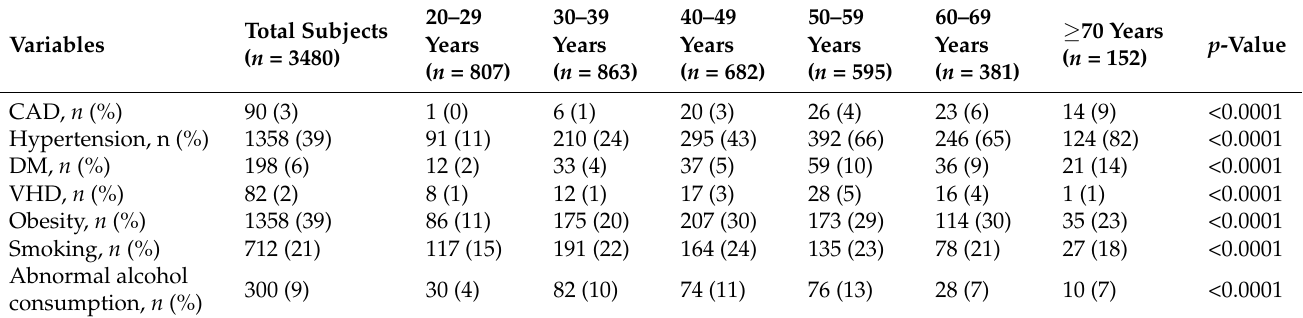
Table 2. Risk factors for HF according to the age groups.